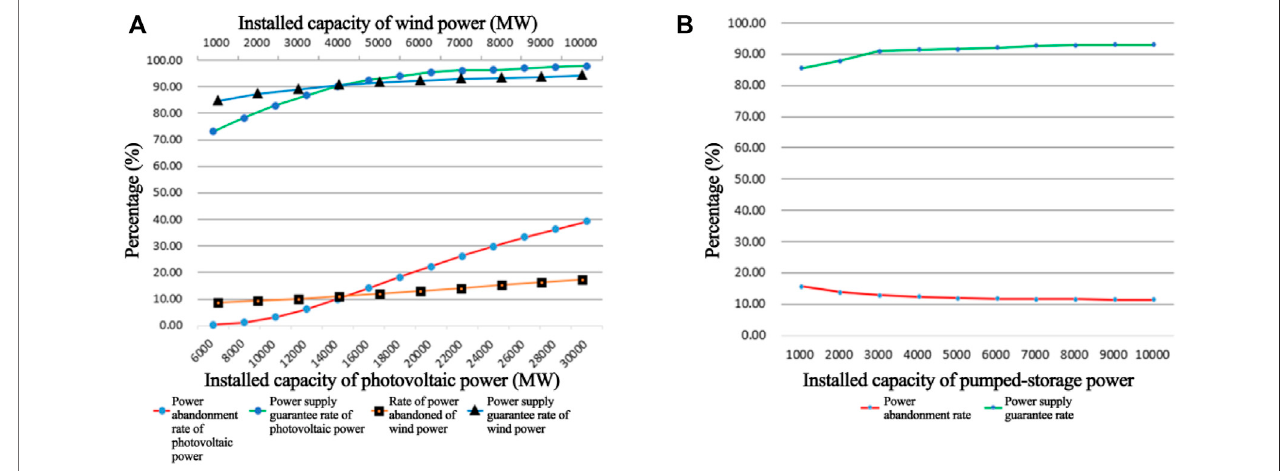
FIGURE 6 | Correlation between output indexes and installed capacity of photovoltaic, wind, and pumped storage power. (A) Correlation between the installed capacity and output indexes of photovoltaic and wind power and (B) correlation between installed capacity and output indexes of pumped storage power.